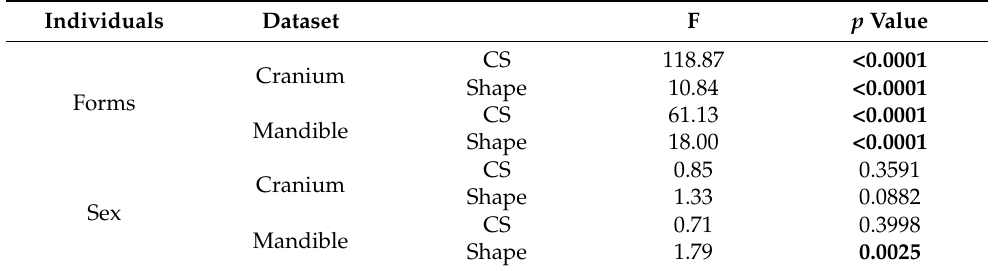
Table 5. Procrustes ANOVA results (F: Goodal’s F, CS: centroid size, Pill: Pillai trace, boldfaced: a significant difference).